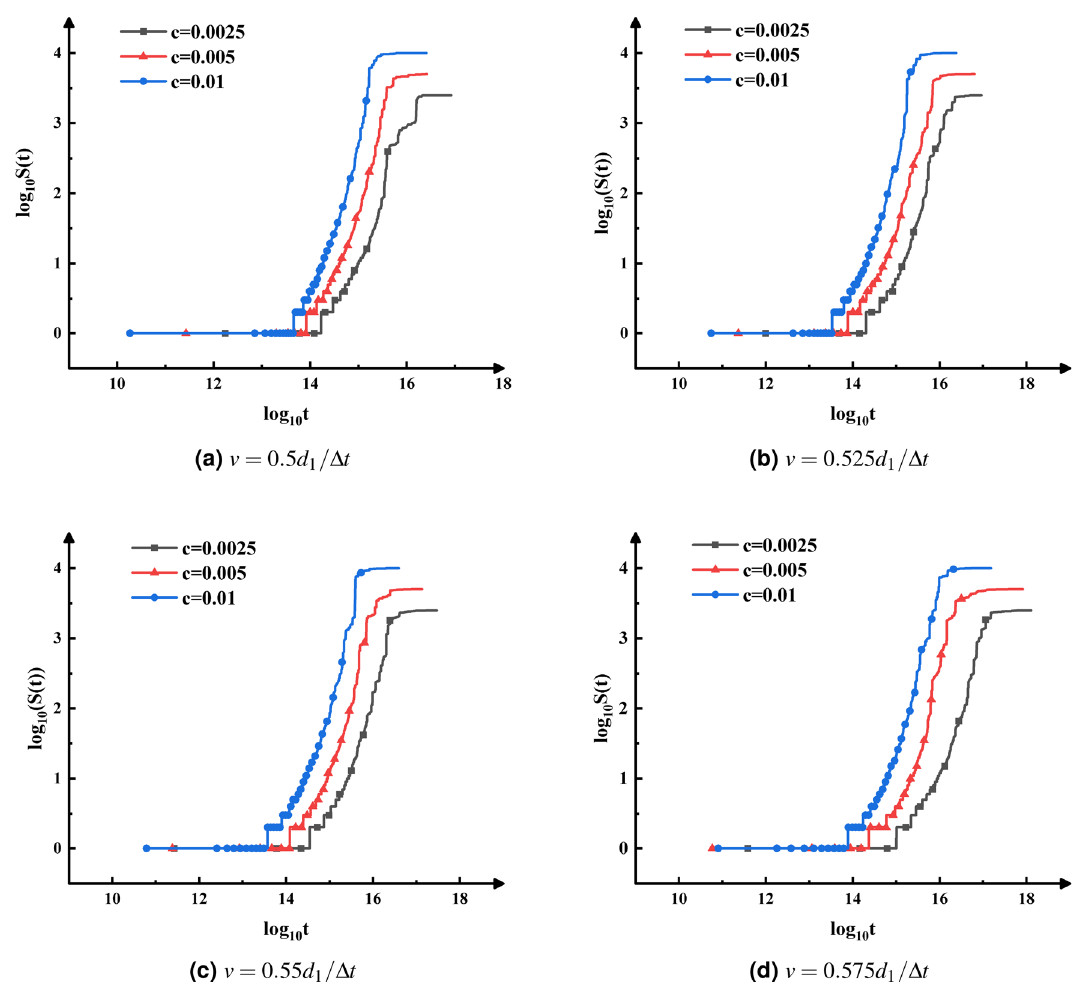
Figure 4. A log–log plot of the weighted average cluster size, S ( t ), as a function of time t , for different initial particle concentrations and